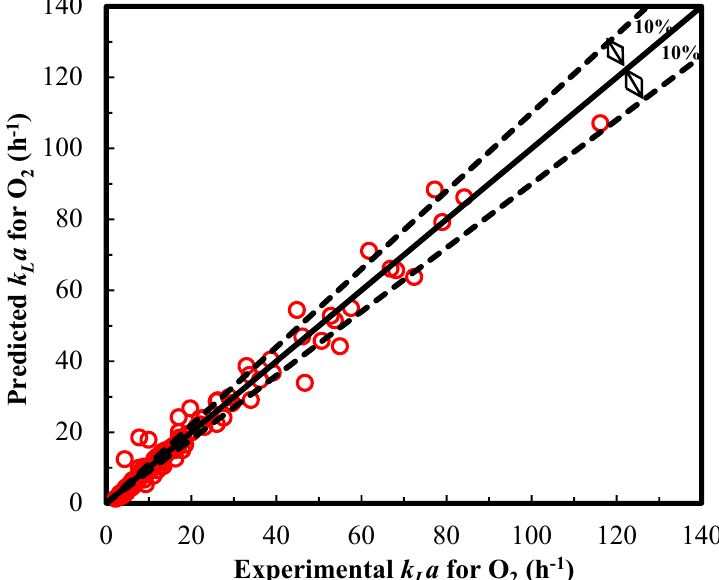
Figure 5. Predicted versus experimental k L a for O 2 at volumetric flow rates between 40 mL min − 1 to 630 mL min − 1 and 37 °C, agitation speeds range from 150 rpm to 900 rpm in the 3 L and 5.6 L working volumes.